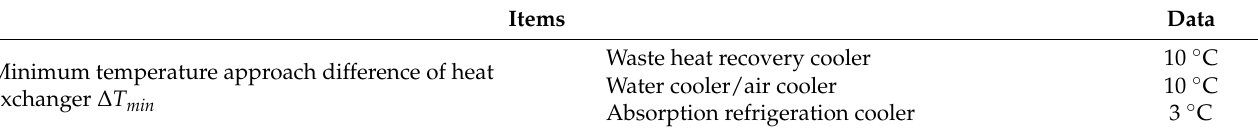
Table 4. Other physical parameters and constrains of case